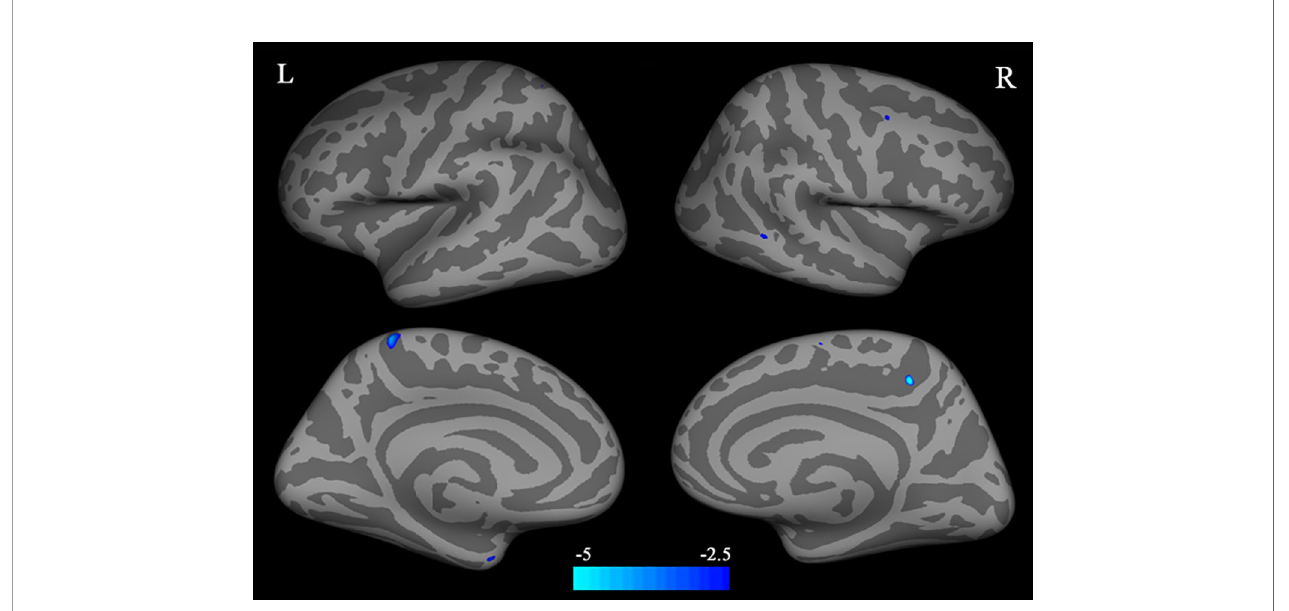
FIGURE 2 | Correlation between BQDSscores and the mean values ofCT of the right caudal middlefrontal. BQDS, Betel Quid Dependence Scale; CT, cortical thickness.